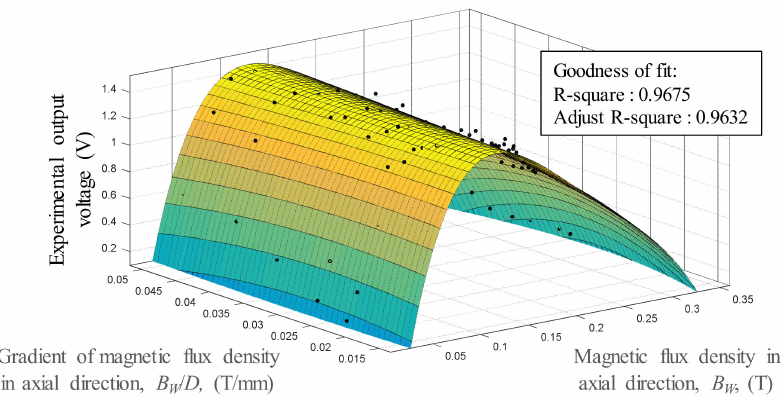
Figure 13. Response surface methodology model expresses the relationships between V , B w , and B w /D